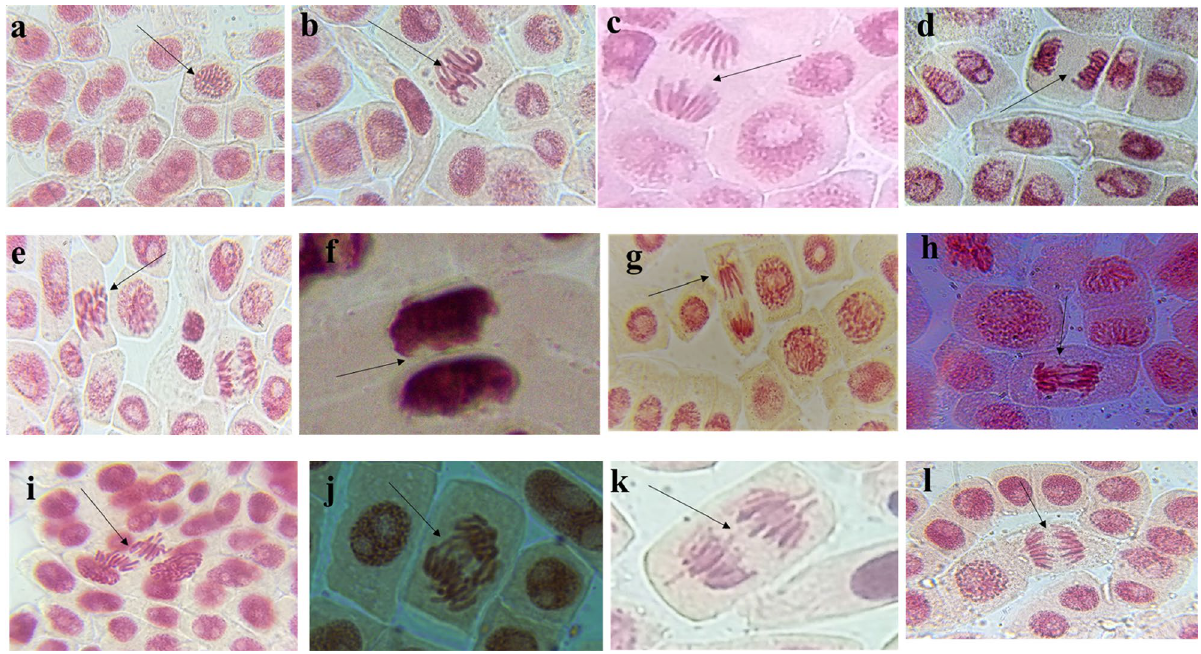
Figure 2. Normal stages of mitosis. ( a ) prophase; ( b ) metaphase; ( c ) anaphase; ( d ) telophase; chromosomal aberrations; ( e ) c-metaphase; ( f ) stickiness at telophase; ( g , k ) vagrant chromosomes; ( h ) chromatin bridge; ( i ) laggard chromosomes; ( j ) chromosomes fragments/breaks; ( l ) delayed anaphase with bridge.